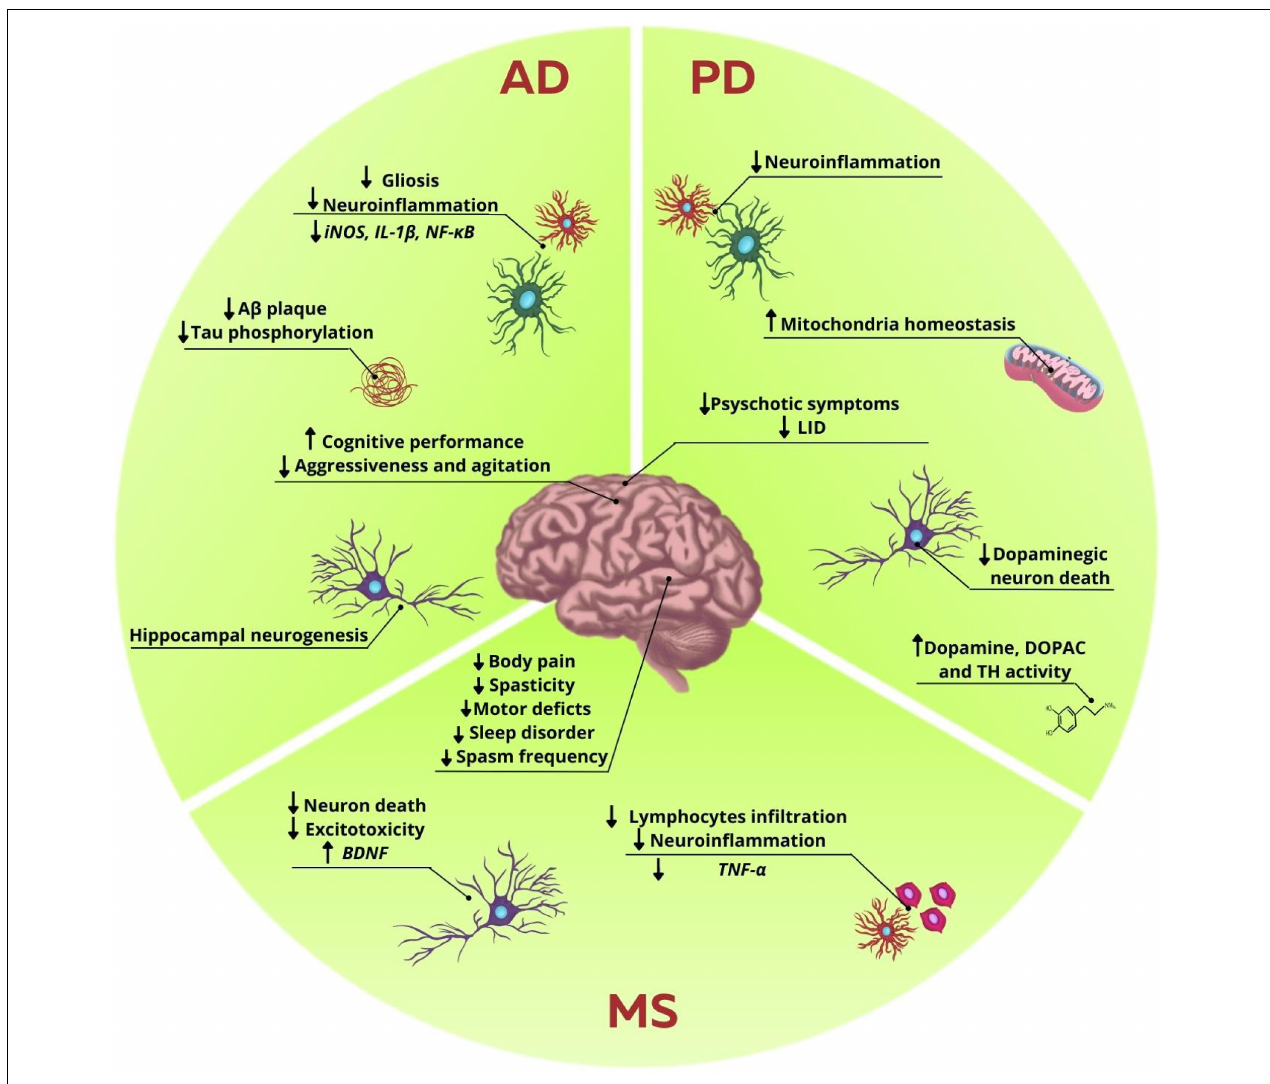
FIGURE 2 | Influence of endocannabinoid system modulation in neurodegenerative diseases disturbances. In AD, ECS modulation reduces A β plaques and tau phosphorylation. It was also observed a decrease in gliosis and neuroinflammation, marked by the reduction in proinflammatory markers, such as iNOS, IL-1 β , and NF- κ B. Hippocampal neurogenesis was also observed. There is an increase in the cognitive performance and decrease of agitation and aggressiveness in patients. In PD, studies showed a decrease in neuroinflammation and in dopaminergic neuron death, while enhancing the levels of dopamine, DOPAC and TH activity. It was also observed an increase in mitochondrial homeostasis, and decrease of neuroinflammation. Behavior improvements are reduction in psychotic symptoms and LID. In MS excitotoxicity and neuron death are decreased, while there is an increase in BDNF levels. Neuroinflammation is also decreased with the reduction in lymphocytes infiltration and release of proinflammatory cytokines, such as TNF- α . There are several benefits regarding secondary symptoms, such as decrease in body pain, motor deficits, spasticity, sleep disorder, and spasms frequency, thus collaborating in the improvement of the patients’ life